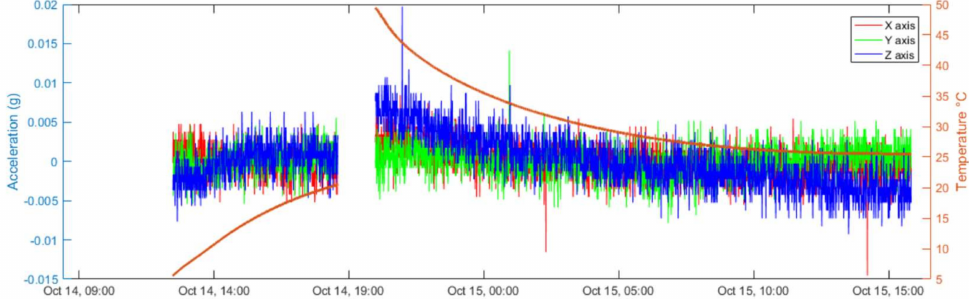
Figure 15. Values of the vibration measurements along the three axes during transient temperature variations, starting from 5 ◦ C and 50 ◦ C, respectively, in the absence of external vibrations. Average values are obtained over mobile window 16